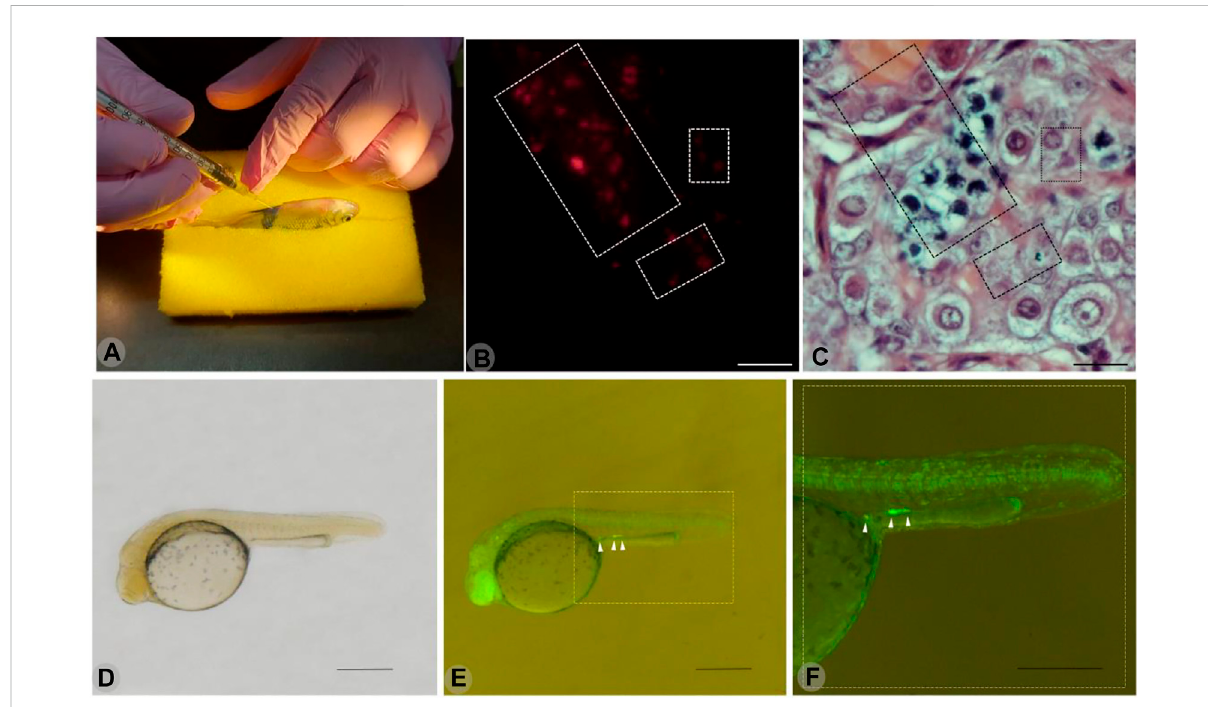
FIGURE 3 Transplantation of spermatogonial stem cells from endangered Brycon orbignyanus through the papillae of sterile juvenile yellowtail tetra Astyanax altiparanae (A) . Detached area indicates the testis containing transplanted cells stained with PKH26 and observed under fl uorescence microscopy (B) . Same histological section visualized under normal light, and hematoxylin-eosin staining shows spermatocytes and spermatogonia from B. orbignyanus . Scale (B – C) : 50 µm. Below is a yellowtail tetra embryo injected with GFP-nos1 3 ′ UTR mRNA from Danio rerio , observed under normal light (D) .Same embryo, observed under fl uorescence microscopy, shows the presumptive primordial germ cells (PGCs) with GFP expression (E) . Gonadal ridge area in detail (F)